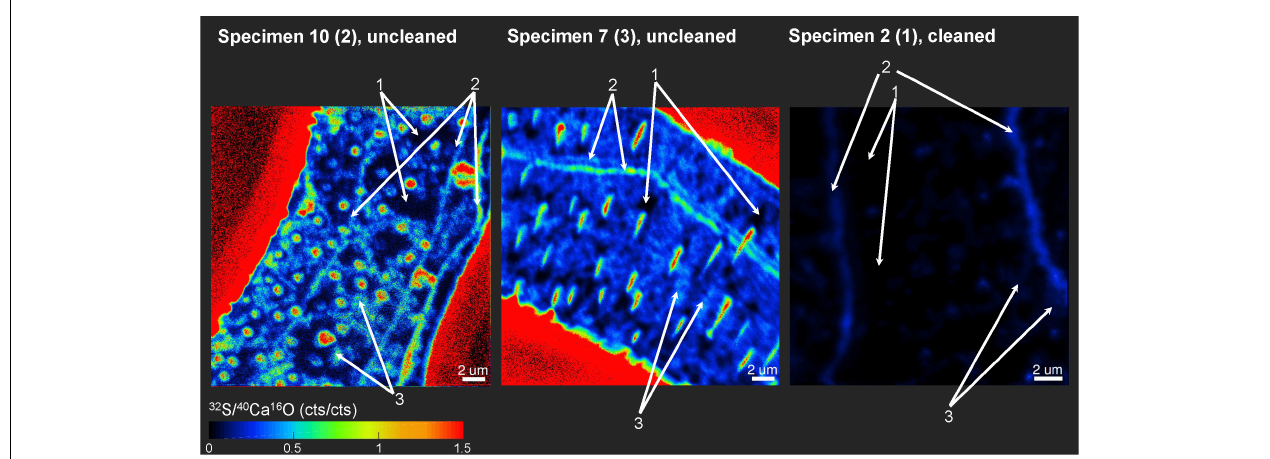
FIGURE 5 | Example of how ROIs for Nano-SIMS analyses were defined between three different classes. ROIs were defined according to the 32 S − / 40 Ca 16 O − distributions. Class 1 represents regions of the lowest 32 S − / 40 Ca 16 O − ratios, possibly free of influence from the organic matrix in the tests. Class 2 represents the distinct 32 S − bandings, while class 3 represents the highest 32 S − / 40 Ca 16 O − ratios outside these bandings. For the uncleaned samples, all class 1 ROIs showed 32 S − / 40 Ca 16 O − ratios < 0.2 cps/cps and all class 3 ROIs > 0.2 cps/cps. For the cleaned samples, all class 1 ROIs showed 32 S − / 40 Ca 16 O − ratios < 0.035 cps/cps and all class 3 ROIs > 0.035 cps/cps. Class 2 ROIs were defined when obvious sulfur bandings were visible. Note that the mapping on specimen 2 (1) was completely located within the foraminiferal calcite, showing no signal from the resin. In the other two specimens, parts of the epoxy resin